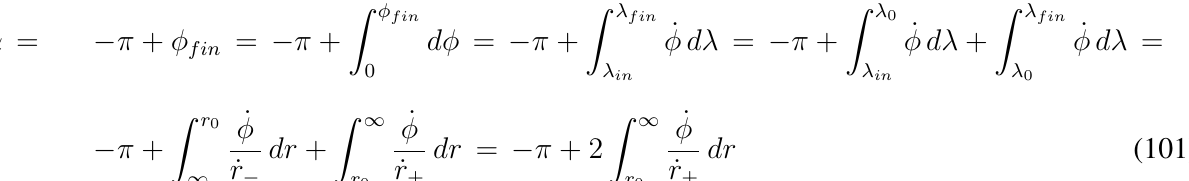
OL is deflected 0 where b is OL